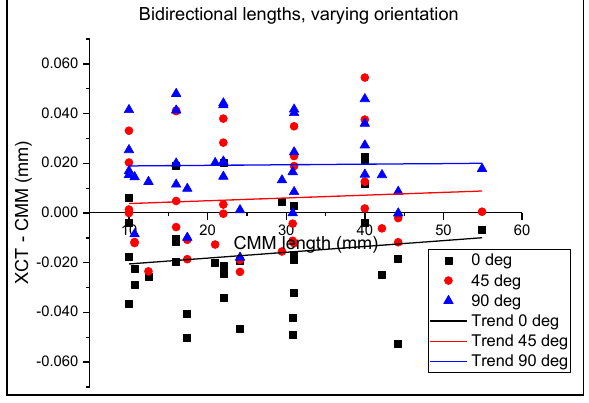
Figure 10: Deviation between bidirectional lengths for holeplate at 1.6 times magnification in three orientations